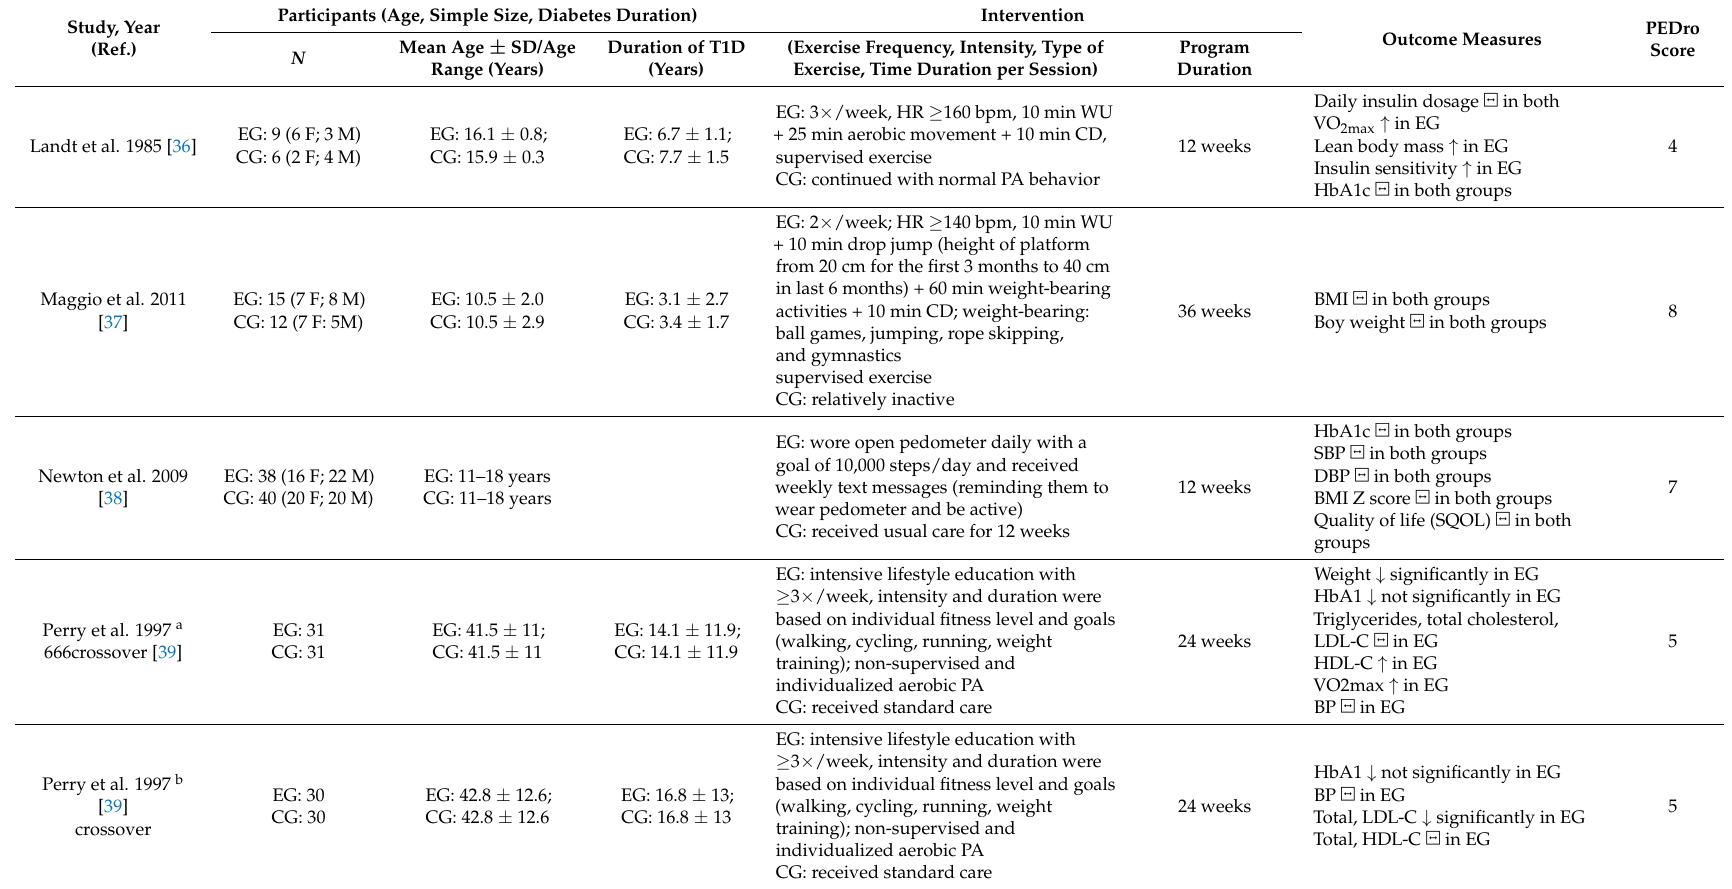
Table 1. Cont. Table 1. Characteristics of the included studies.